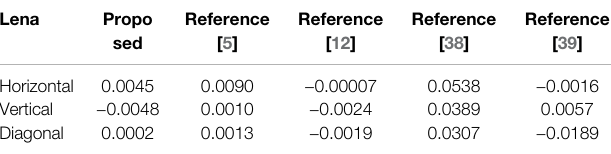
TABLE 6 | Correlation comparison with different scheme results using the Lena image. Lena